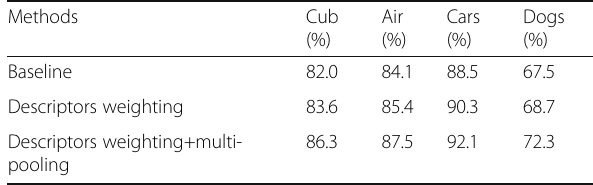
Table 3 Evaluation of descriptors